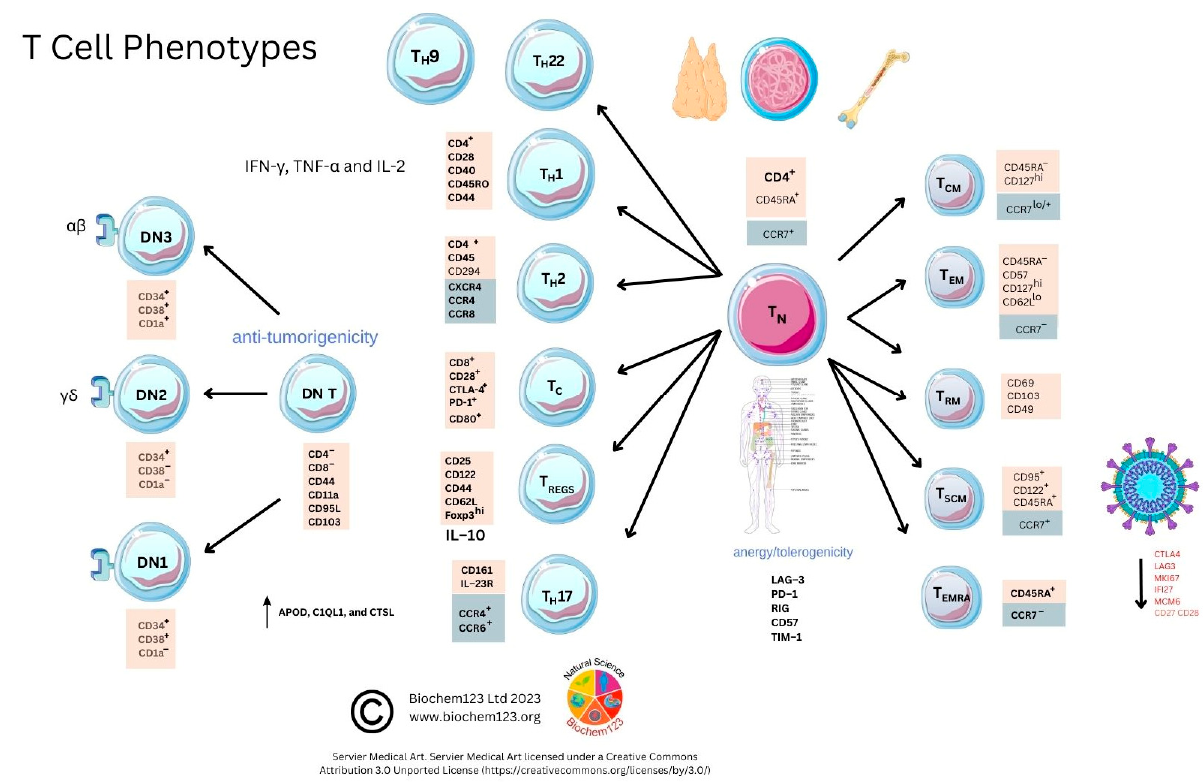
Figure 11. T-Cell phenotype diversity and developmental cellular markers.